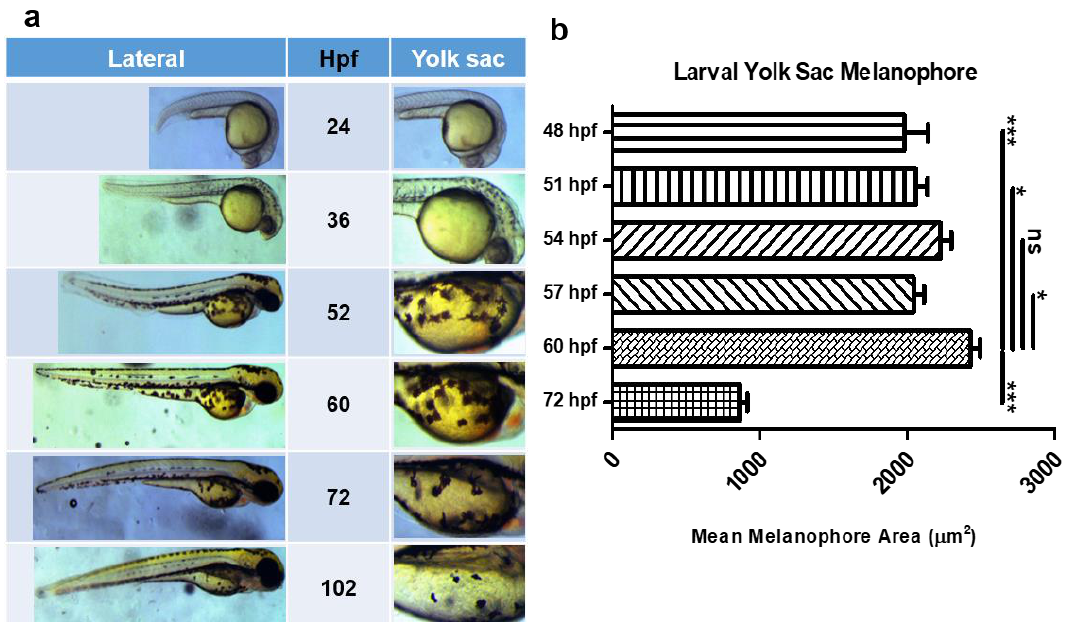
Figure 3. Yolk sac melanophores of developing zebrafish larvae. ( a ) Table of images depicting zebrafish larva developmental stages according to the number of hours post fertilization (hpf) with magnification of the yolk-sac region. ( b ) Quantification of average area of yolk sac melanophores at 3 h intervals starting from 48 hpf to 60 hpf for wild-type zebrafish. One-way ANOVA with post-hoc Dunn’s multiple comparison test was used for statistical significance between groups; data represented as mean ± SEM; * p < 0.05, *** p < 0.001, ns = not significant.